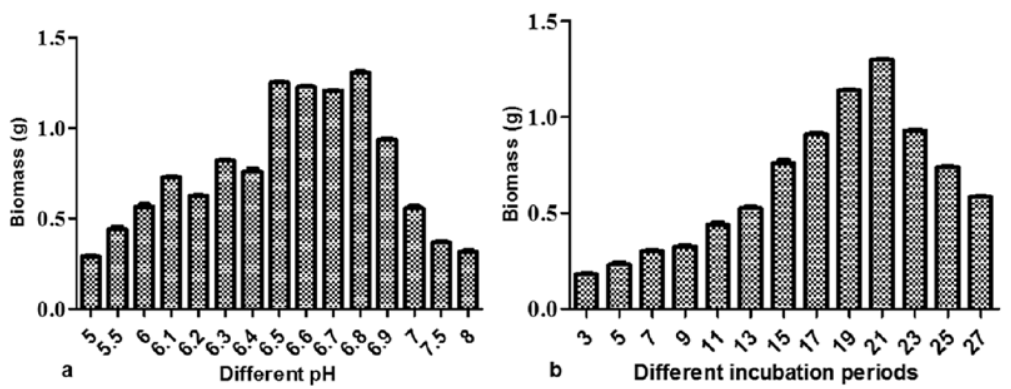
Fig. 4. Growth of M . karstenii in different physical parameters: (a) pH; (b) incubation periods